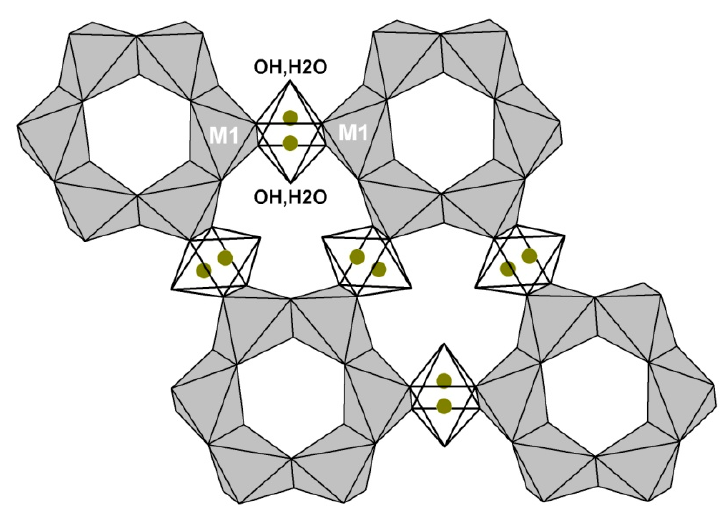
Figure 17. Pairs of differently oriented M 2O 5 pyramids in the structure of a V Na-dominant sample viewed along (001) [15].